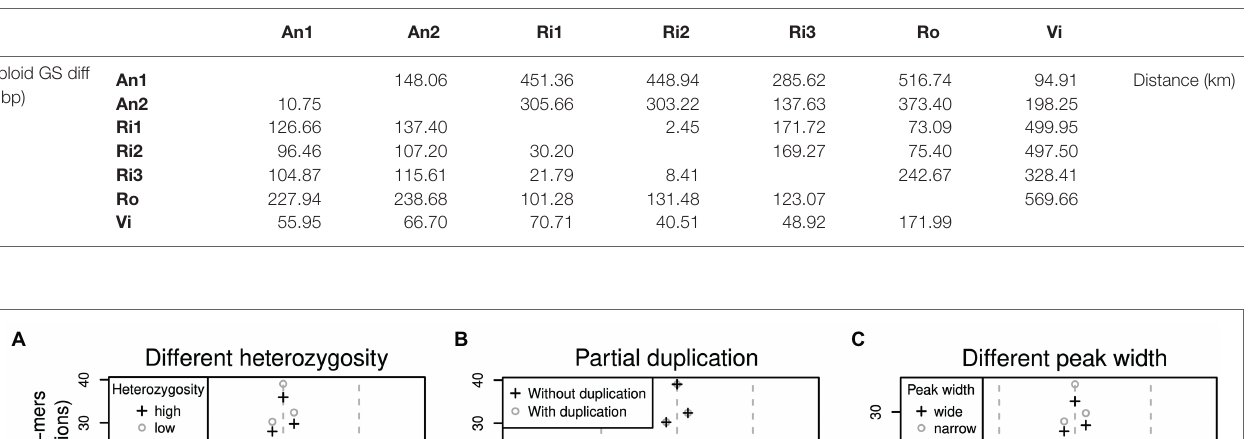
TABLE 2 | Pairwise genome size differences (lower triangle) and geographic distances (upper triangle) between sampling sites.